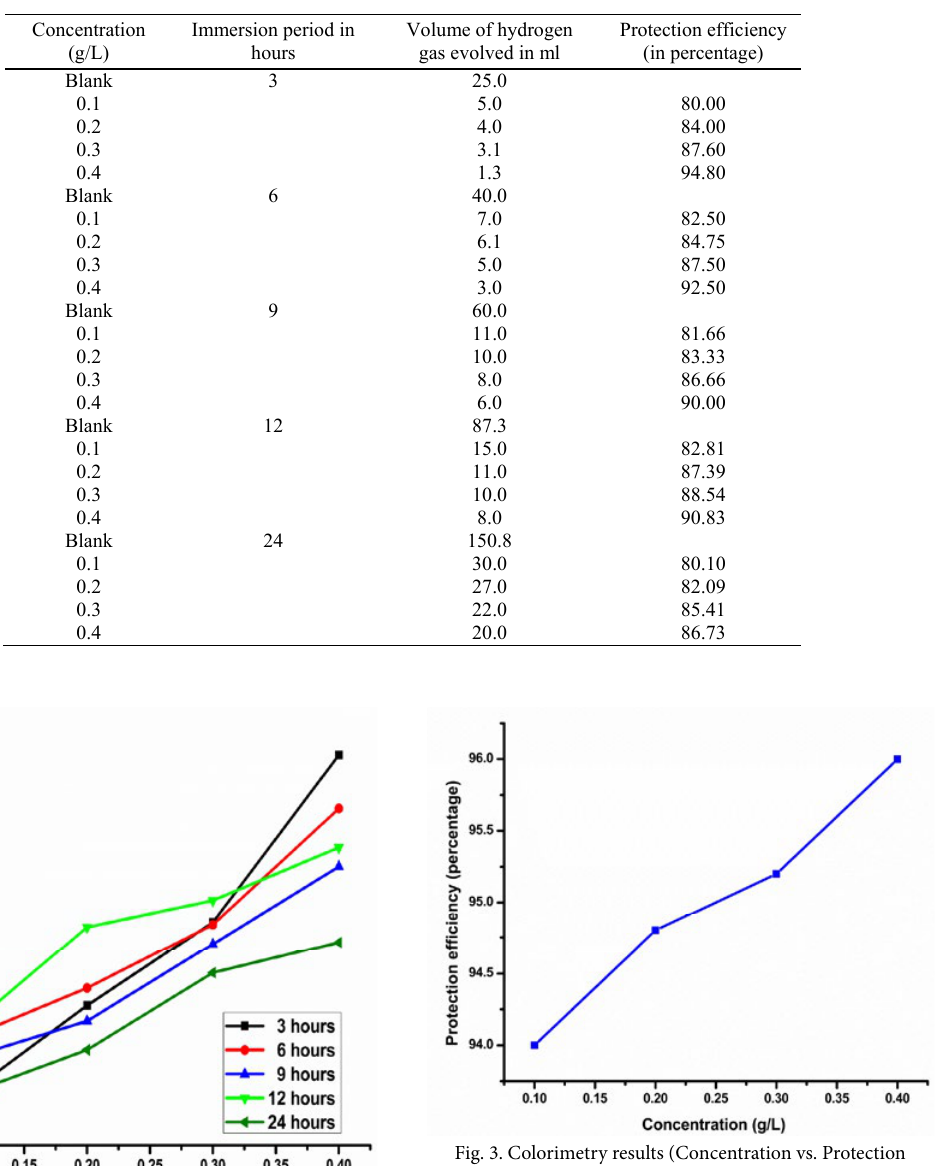
Table 1. Gasometric results